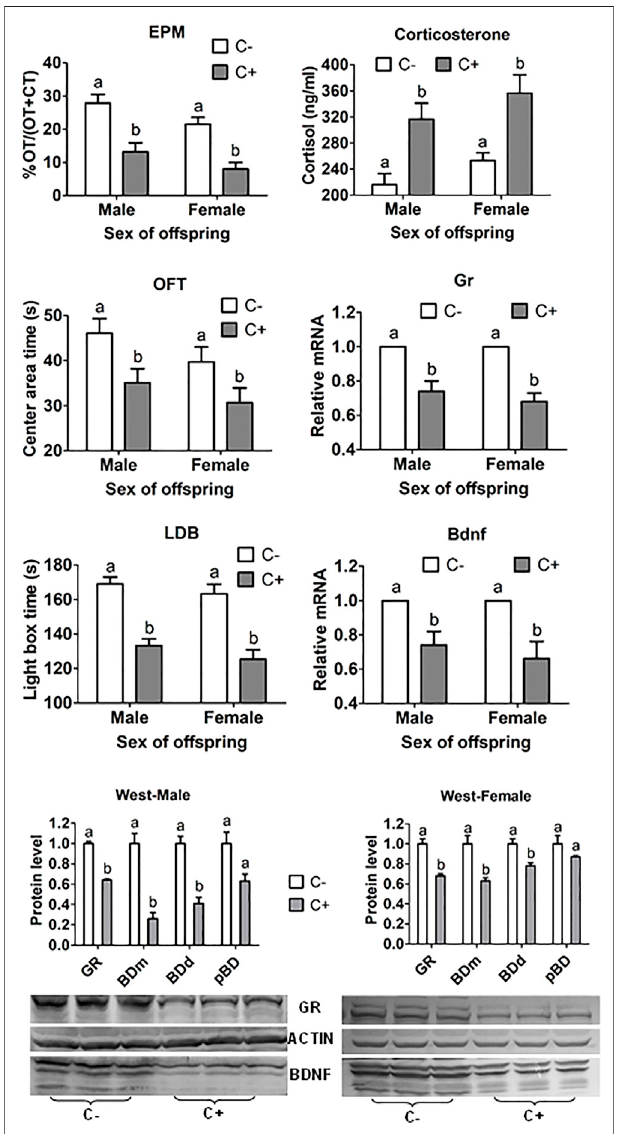
FIGURE1| ALB,serumcorticosteroneconcentration,andhippocampal levelsofGrandBdnfmRNAsand protein inoffspringafter transferofembryos cultured with (+) or without ( − ) corticosterone (C). The ALB was measured by % Open-arm time (OT)/OT + closed arm time (CT) of EPM, and times (s) incentral areaofOFTand inlightboxoftheLDB test. WhilemRNAlevelsofGr and Bdnf were measured by RT-PCR, their protein levels were measured by western blotting. For behavioral tests, each treatment was repeated three times and each replicate contained about 10 offspring from three to fi ve recipients. For corticosterone measurement, each treatment was repeated three times with each replicate containing two to three serum samples from twotothreeoffspringeachfromadifferentrecipient.ForRT-PCRandwestern blotting, each treatment was repeated three times with each replicate containing three hippocampus samples from three offspring each from a different recipient. Three forms of BDNF were observed including BDNF monomer (BDm), BDNF dimer (BDd) and pro-BDNF (pBD). Levels of GR and different BDNF forms were expressed as ratios of GR or BDNF/ β -actin. a,b: Values with a different letter above bars differ signi fi cantly ( p <